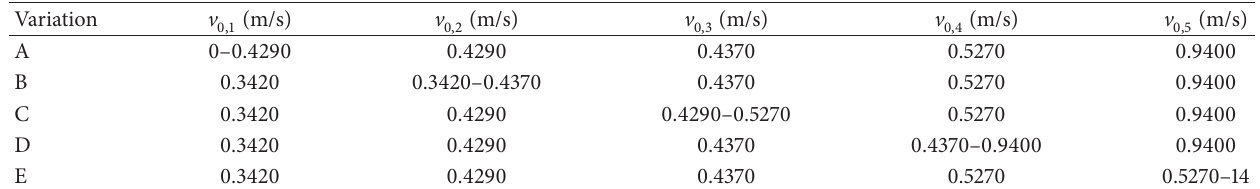
Table 2: First variation of initial flow